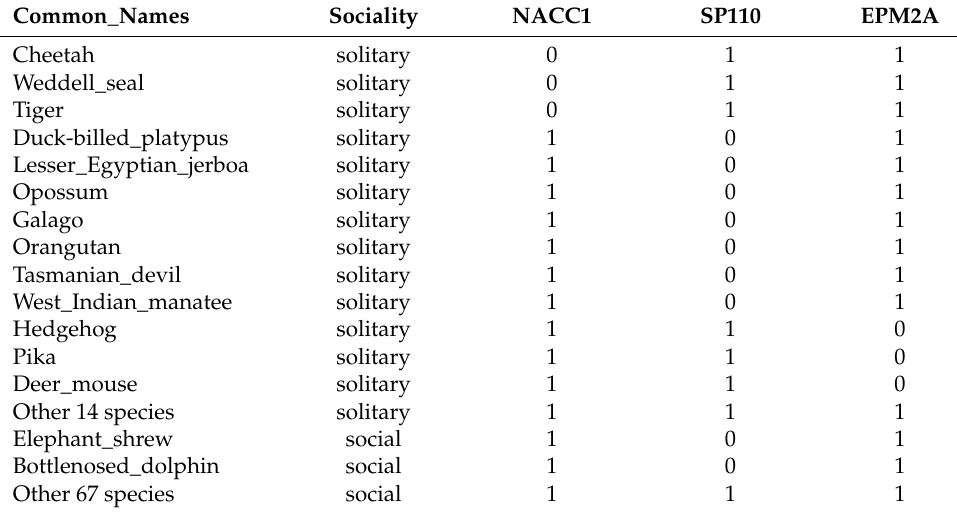
Table 1. TF loss in NACC1, SP110 and EPM2A associated with